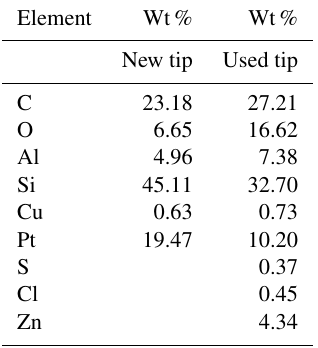
Figure 8. SEM micrographs of the PIC1 AFM tip. The upper panels correspond to the micrographs of the tip before usage and the lower panels to those of the tip after usage. Panels (a) and (c) correspond to a magnification of 3.00KX and panels (b) and (d) to magnifica- tions of 8.00KX and 15.00KX, respectively.